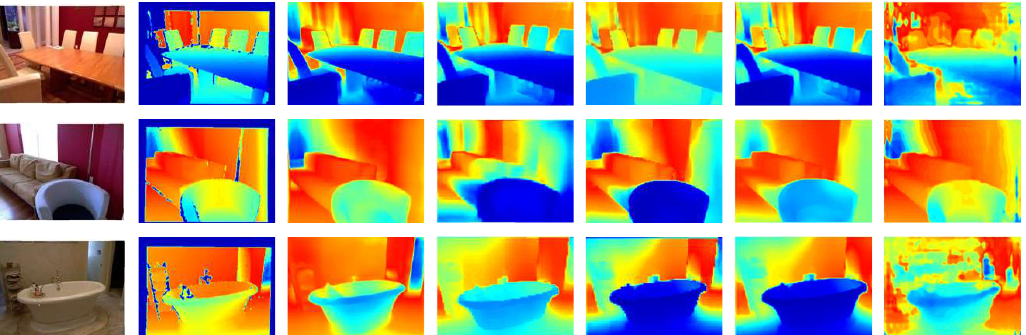
Figure 1. Qualitative comparison of five state-of-the-art-monocular depth estimation methods. From left to right: Input Image, Ground Truth, BTS [49], DeepV2D [50], DenseDepth [47], MonoResMatch [38] and DORN [18].